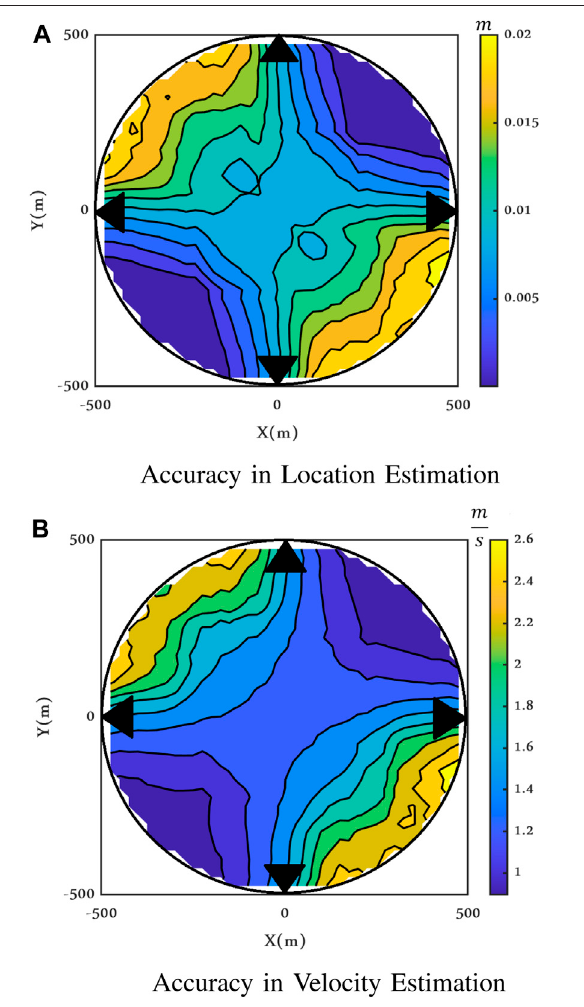
FIGURE 17 | Maximum achievable accuracy when the target is moving, Clutter Model I, ] = 2.1 and SCR = − 15 dB. FIGURE 18 | Maximum achievable accuracy when the target is moving, Clutter Model II, ρ = 0.9, ] = 2.1, and SCR = − 15 dB.